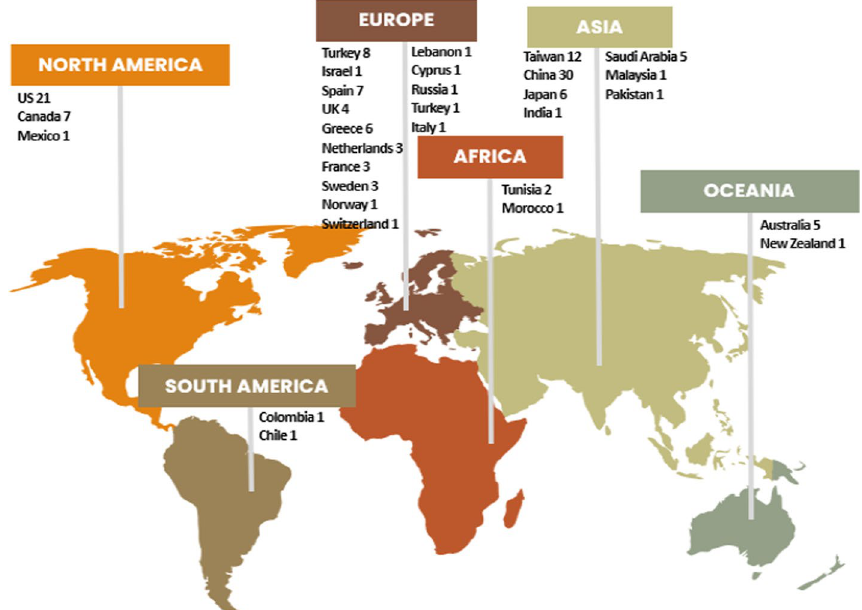
Fig. 2 Geographical distribution of the AIEd HE